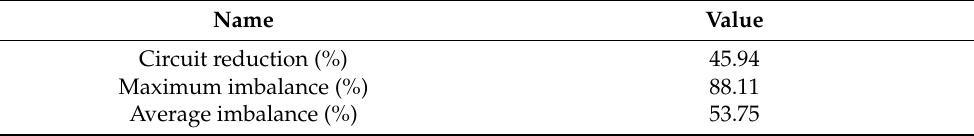
Table 2. Partition statistics for Circuit 5 feeder, two zones. Table 3. Partition statistics for Circuit 5 feeder, four